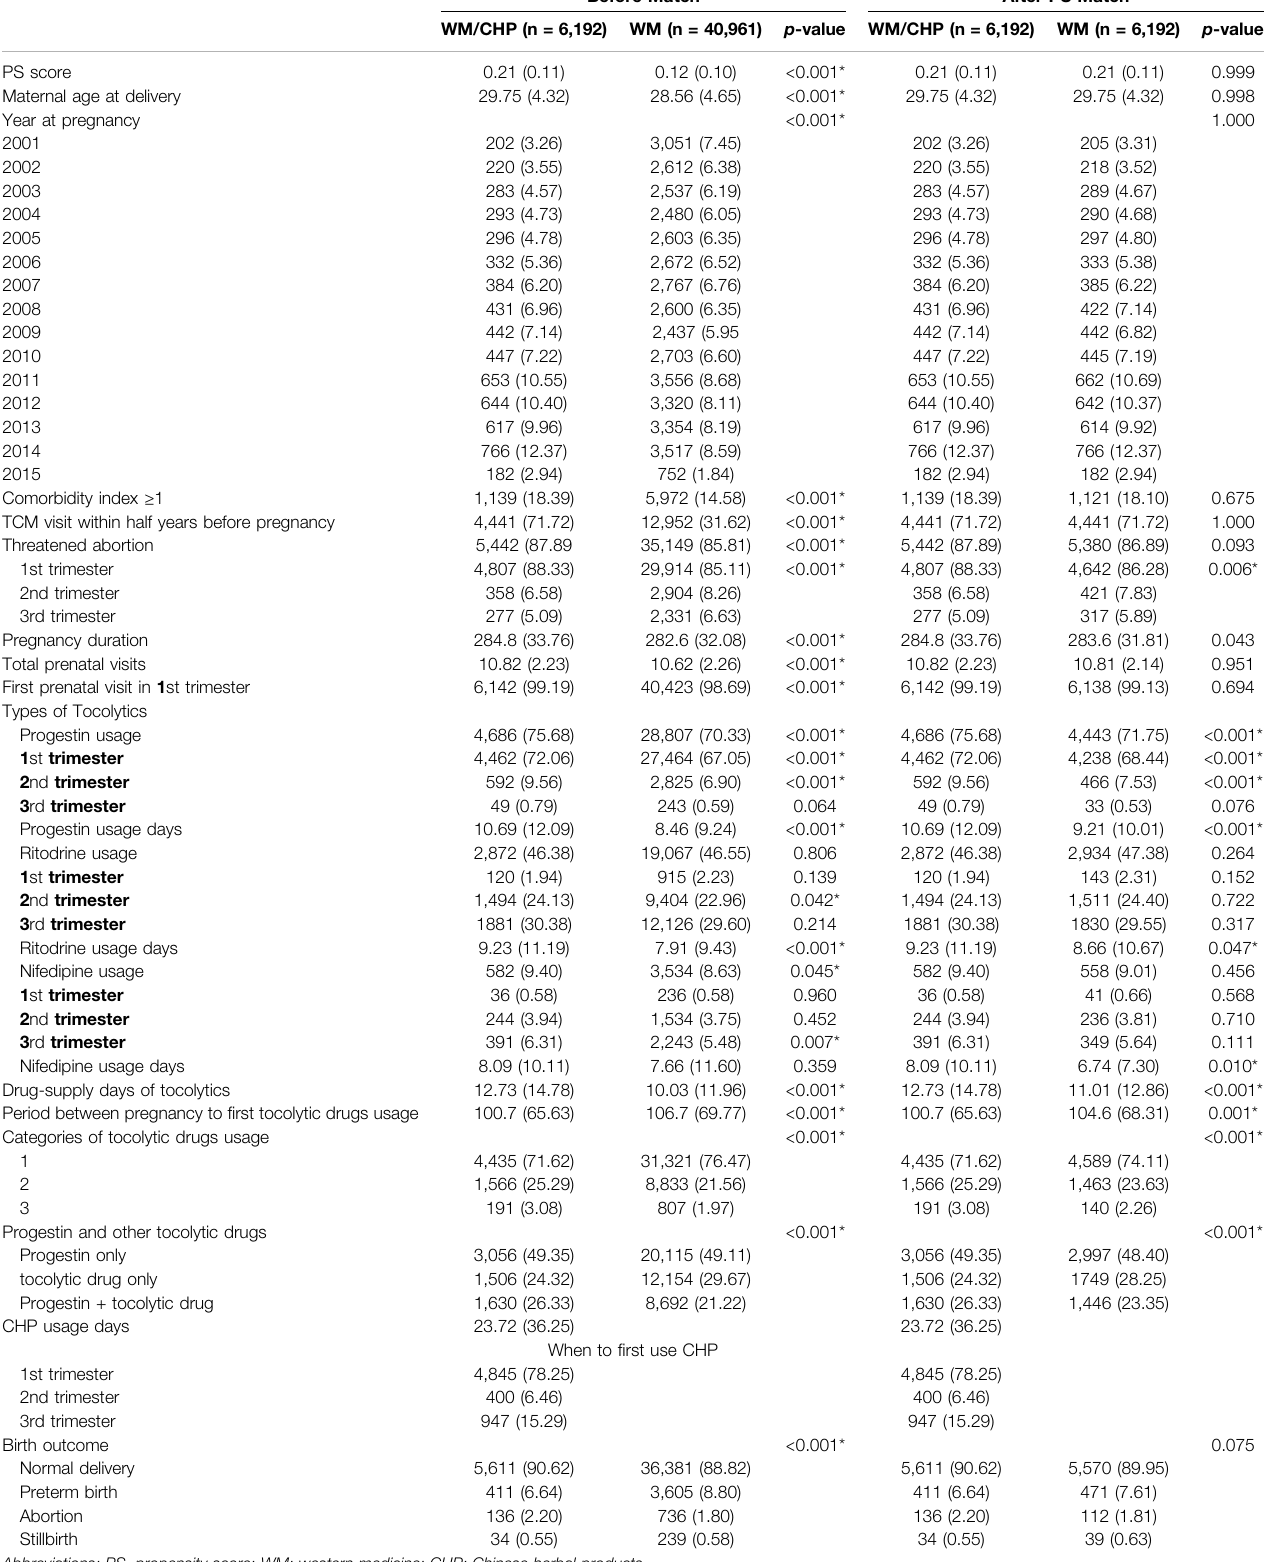
TABLE 1 | Characteristics of pregnant women classi fi ed according to the use of Chinese herbal